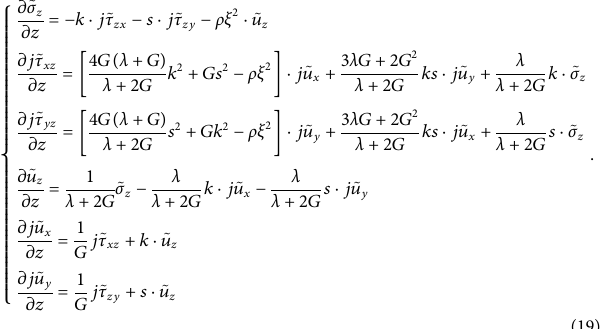
FIGURE 1 | Simpli fi ed model of vibration